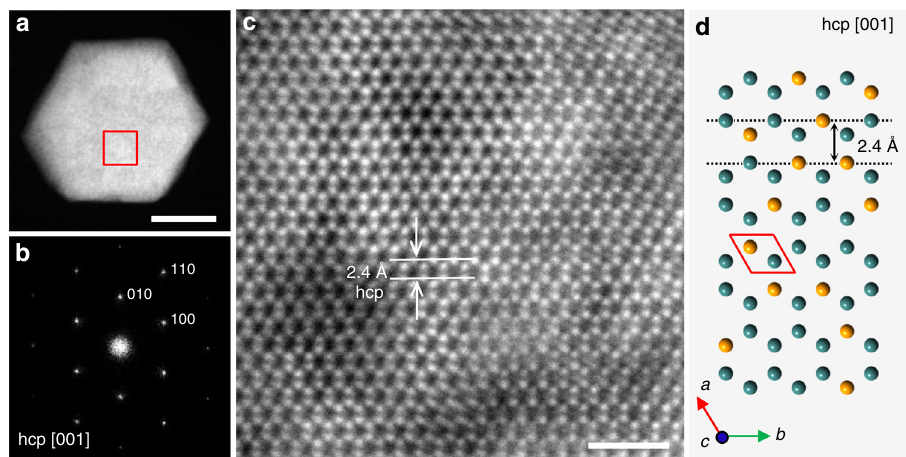
Fig. 4 STEM analysis and crystal model of hcp-AuRu 3 NPs. a Low-magni fi cation HAADF-STEM image of an hcp-AuRu 3 NP. b The corresponding FFT pattern of the NP in ( a ). c Atomic resolution HAADF-STEM image of the red square region in ( a ). d Model for the atomic arrangement of the hcp structure viewed along the [001] direction. The unit cell is shown as the red frame. The scale bars in ( a ) and ( c ) are 20 and